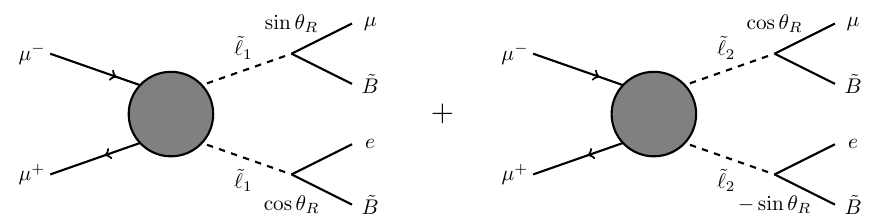
Figure 5. When mass splitting of the two mass eigenstates are small, interference between the two Feynman diagrams suppresses signal cross section due to the opposite